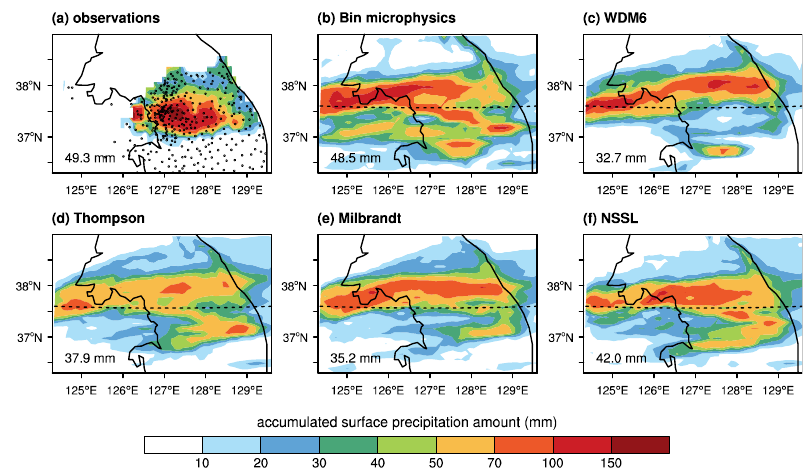
Figure 2. The 18-hr accumulated surface precipitation amount ( a ) observed by AWSs and simulated using the ( b ) bin microphysics scheme, ( c ) WRF Double-Moment 6-class (WDM6) scheme, ( d ) Thompson–Eidhammer scheme, ( e ) Milbrandt scheme, and ( f ) National Severe Storms Laboratory (NSSL) scheme. The fields of accumulated precipitation amount are obtained by averaging observed or simulated precipitation amounts in the 0.15° × 0.15° box centered at each grid point. Circles in ( a ) indicate the locations of AWSs. Dashed lines in ( b – f ) indicate the 37.6° N line, which “roughly” divides the northern precipitation and the southern precipitation. The accumulated surface precipitation amount averaged over the AWS locations are given in the bottom left corner of each panel.